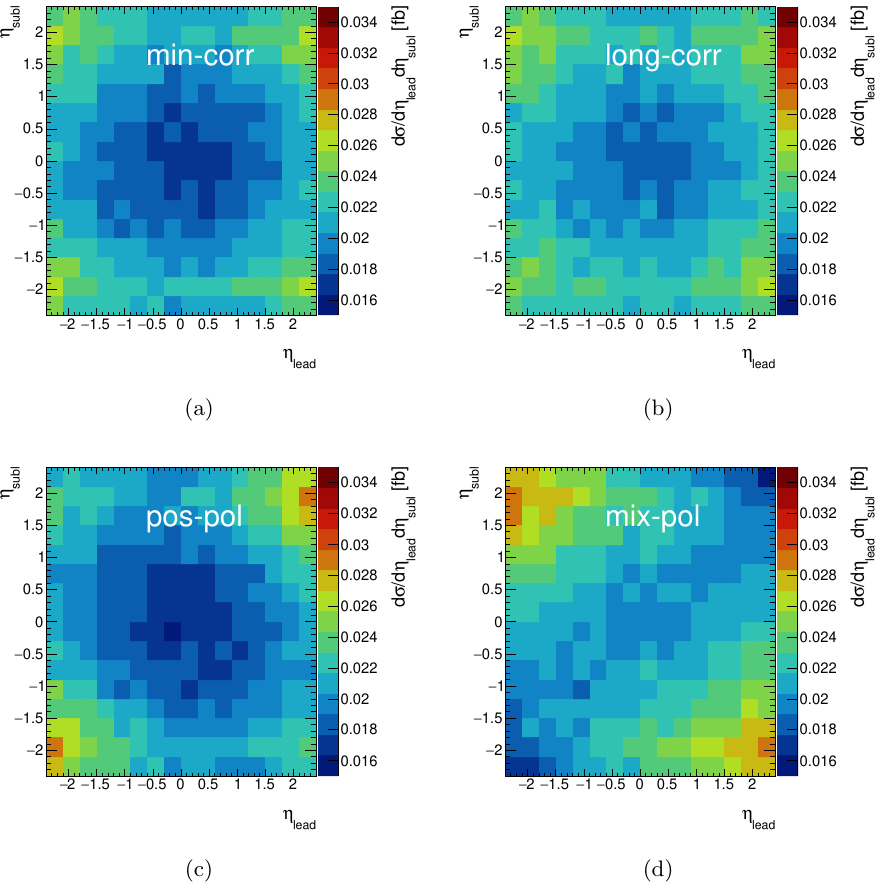
Figure 12 . The 2D rapidity plane similar to (cid:12)gure 2, here with (cid:12)nal-state muons (at HL) and within the phase space (5.1). Top left: minimally correlated scenario. Top right: longitudinal correlation. Bottom left: positive polarization. Bottom right: mix